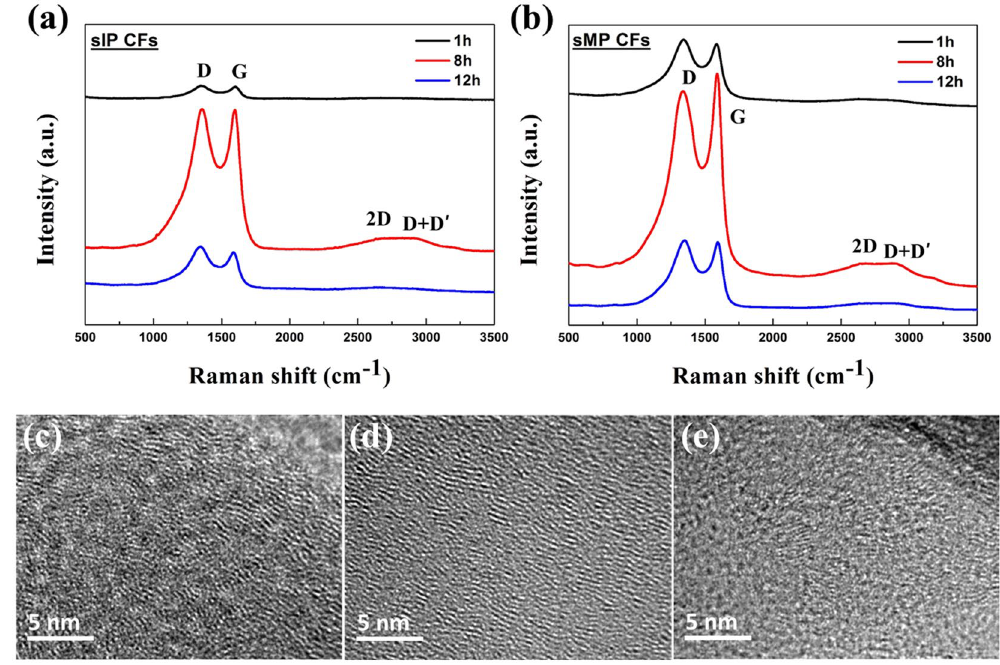
Figure 5. Raman spectroscopy of ( a ) sIP CFs and ( b ) sMP CFs. The stacked crystallite heights and inter- spacing layer information for ( c ) sMP4 CF, ( d ) sMP8 CF, and ( e ) sMP12 CF were supported by TEM